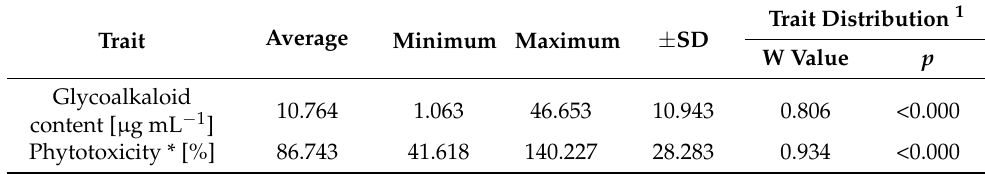
Table 1. Summary of the glycoalkaloid content and phytotoxicity distribution in the 113 individuals. Trait